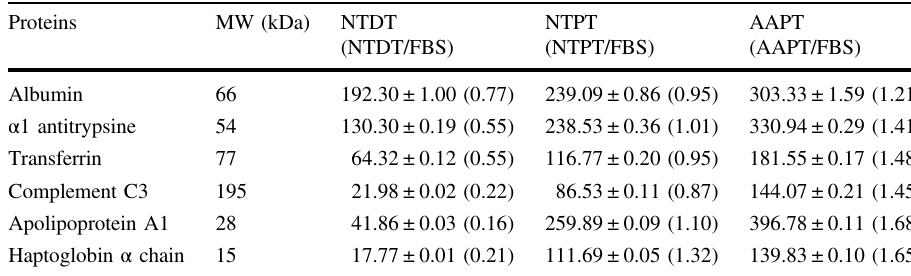
Table 1 Intensities of protein bands of the adsorbed proteins on NTDT, NTPT and AAPT